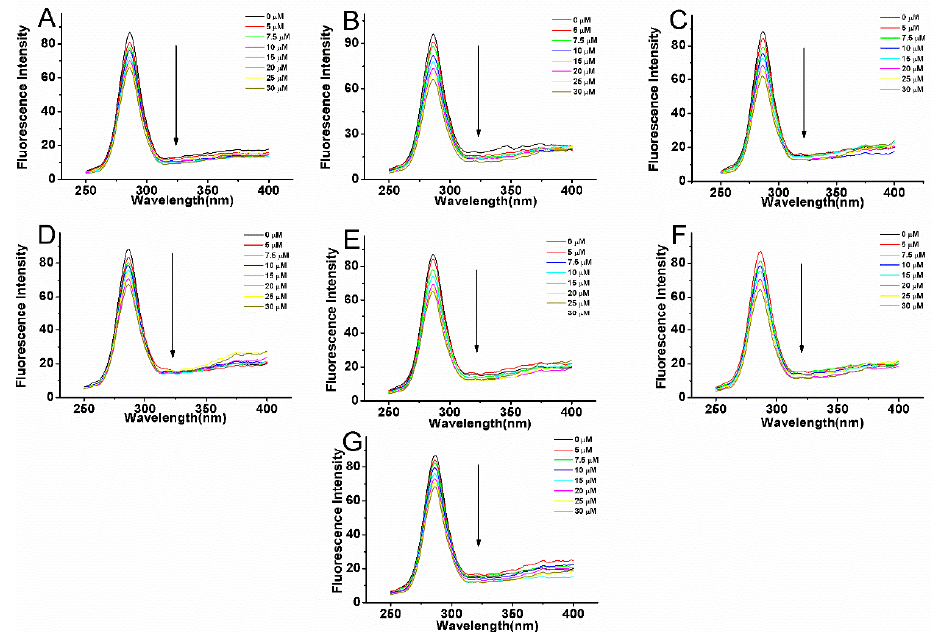
Figure 6. Synchronous fluorescence ( Δλ = 60 nm) of BSA (5 μ M) with variable concentrations of compounds 1 ( A ), 2 ( B ), 3 ( C ), 4 ( D ), 5 ( E ), 6 ( F ), 7 ( G ) at the excitation wavelength (280 nm) at room temperature in 0.05 mol L − 1 Tris-HCl, pH 7.4. The concentrations of compounds varied from 0 to 30 μ M.